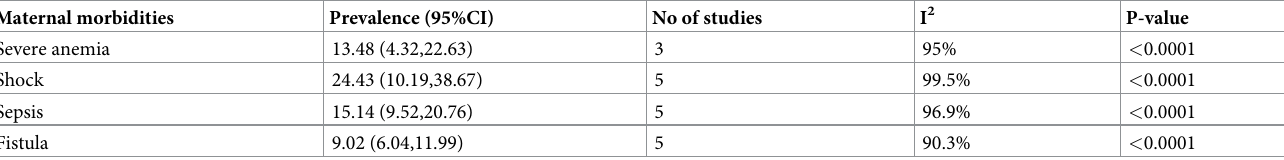
Table 4. Type of maternal morbidities associated with uterine rupture in Ethiopia.